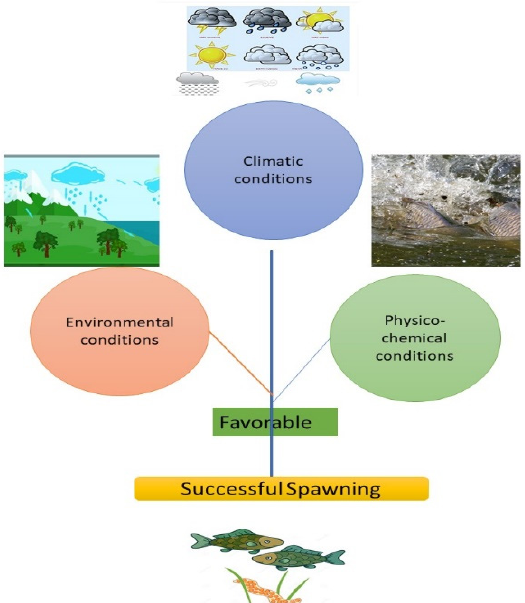
Figure 9. Framework showing the relationship between hydrological conditions and carp spawning